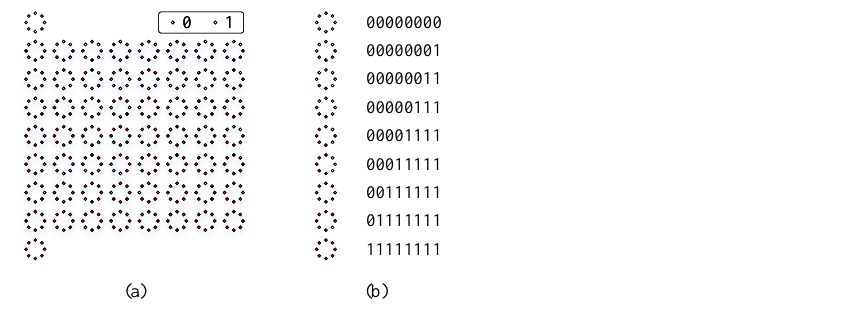
Figure 6. ( a ) 58 uniform pattern LBP codes. ( b ) 9 uniform pattern LBP codes.